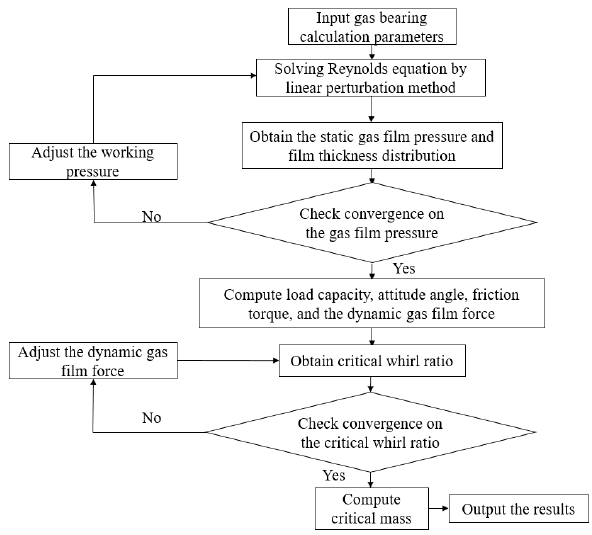
Figure 2. Flow chart of the calculation procedure.